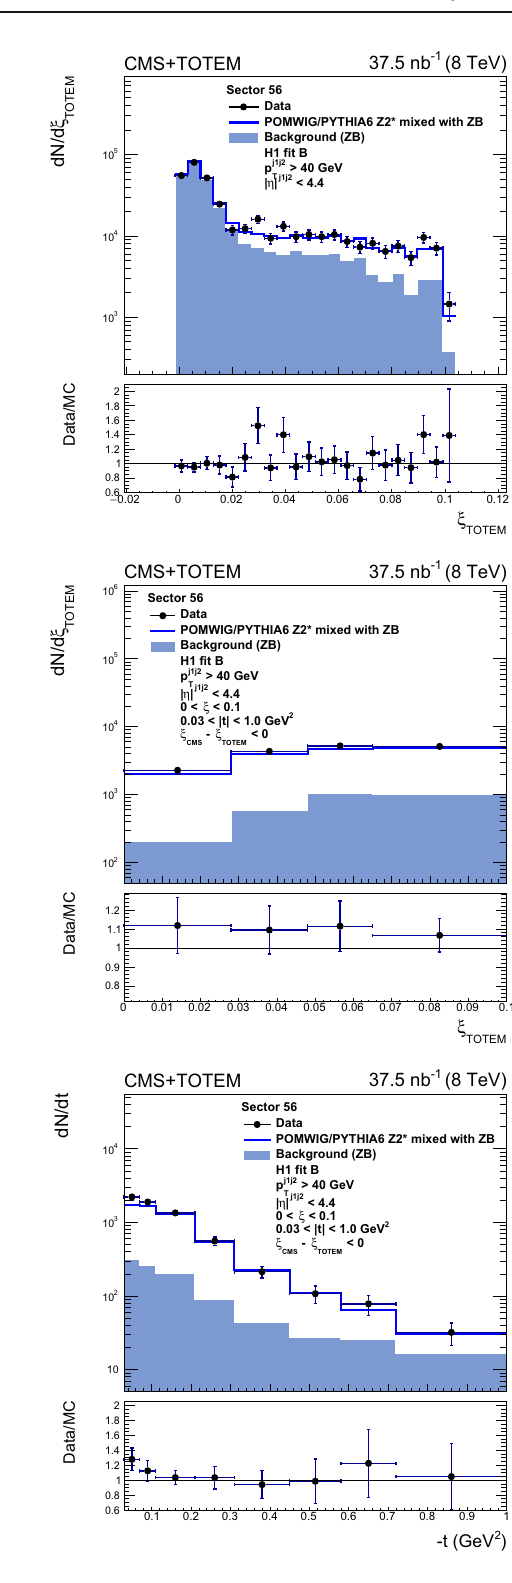
(ZB) data events described in the text. An event with the proton mea- ξ − ξ sured in the RPs contributes to the open histogram (signal) if the proton CMS TOTEM originates from the MC sample, or to the filled histogram (background) if it originates from the ZB